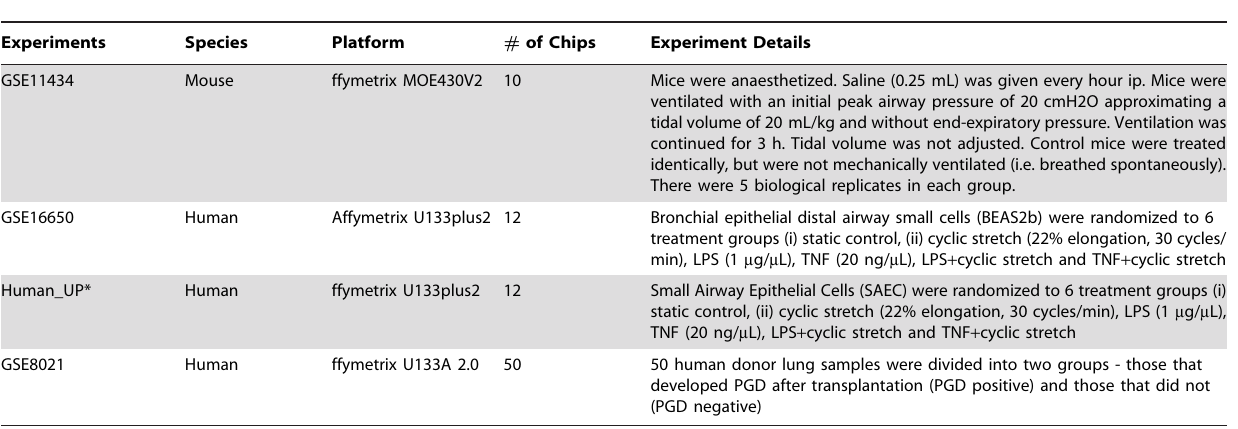
Table 7. Summary of studies used for